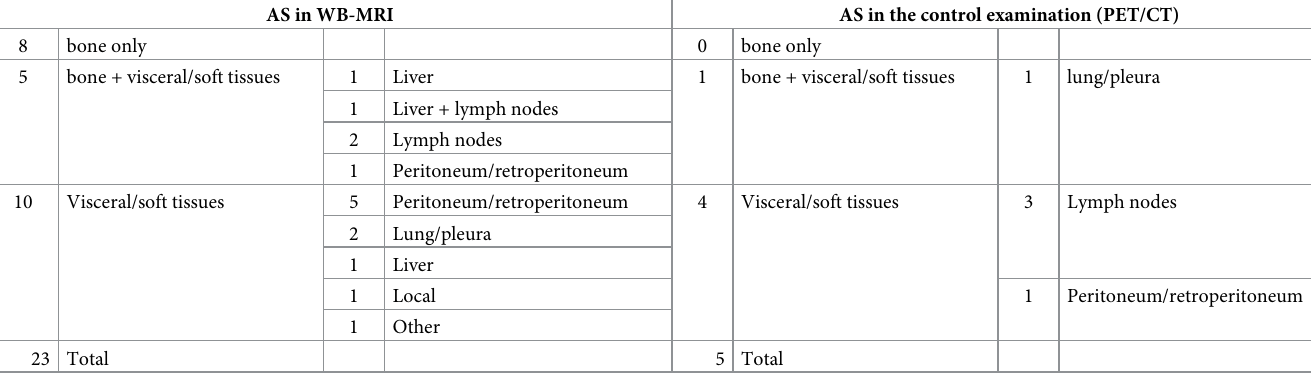
Table 3. Distribution of the additional sites of disease (AS) reported by WB-MRI and by the control examination respectively. AS in WB-MRI